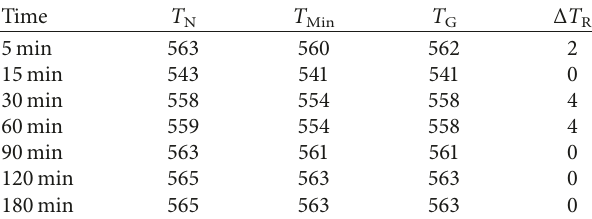
Table 3: Nucleation ( T N ), minimum ( T Min ), and growth tem- peratures ( T G ) and eutectic recalescence for samples with different holding time after combined additions of